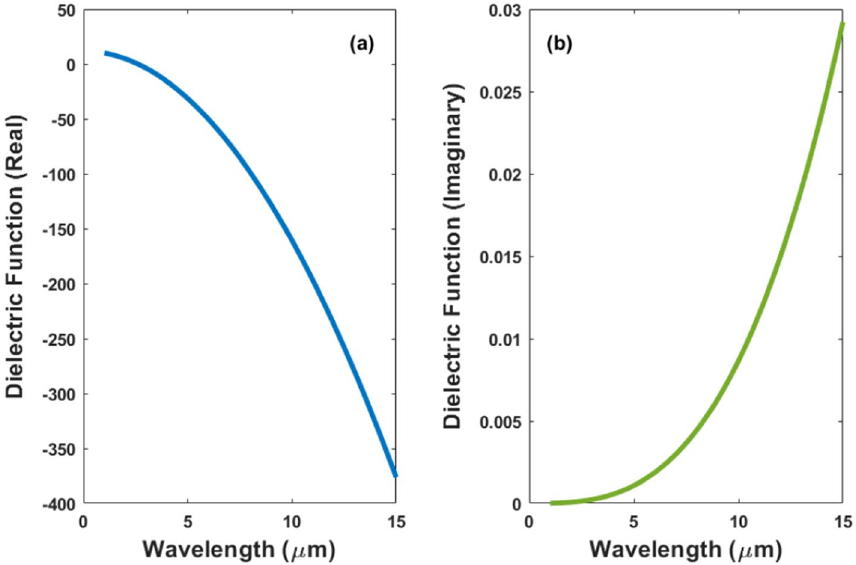
− 3 . For wavelengths